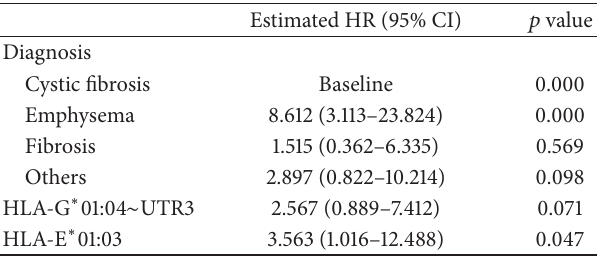
Table 3: Main risk factors for CLAD according to Cox regression multivariate analysis on recipient diagnosis, HLA-G ∗ 01:04 ∼ UTR3 haplotype, and HLA-E ∗ 01:03 allele (HR, hazard ratio; CI,